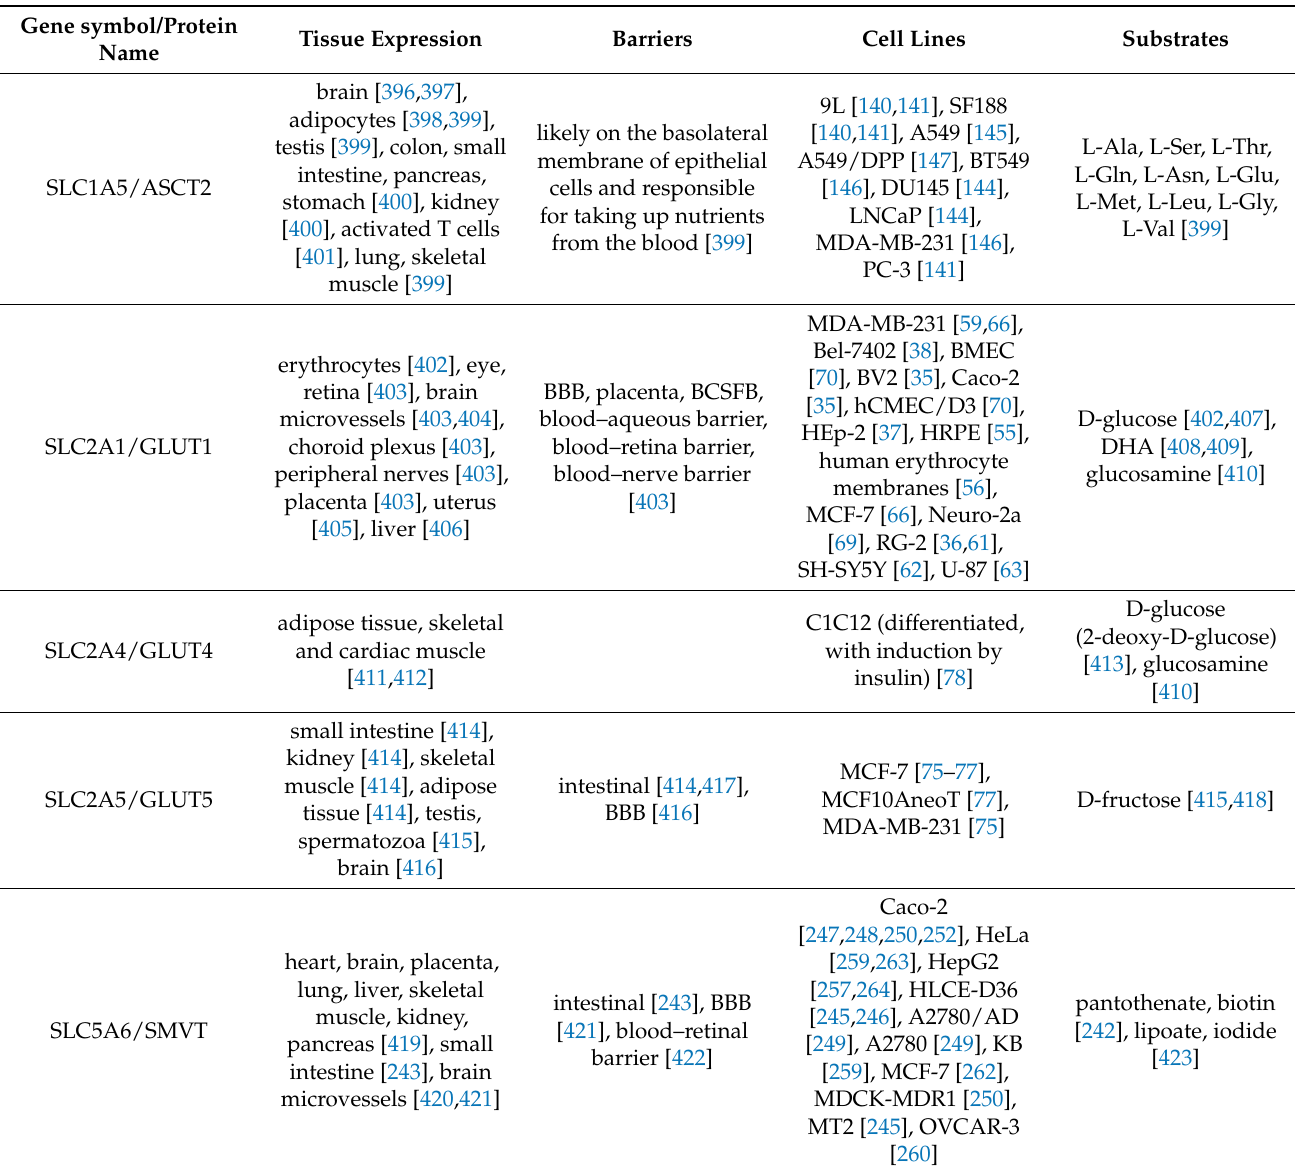
Table 1. SLC transporters used for barrier and organ targeting. The gene symbols and protein names of transporters, their expression in organs and on biological barriers, endogenous substrates and cell lines referenced in this review that have been used to test for corresponding transporter-mediated uptake. Primary cells have not been listed, except in special